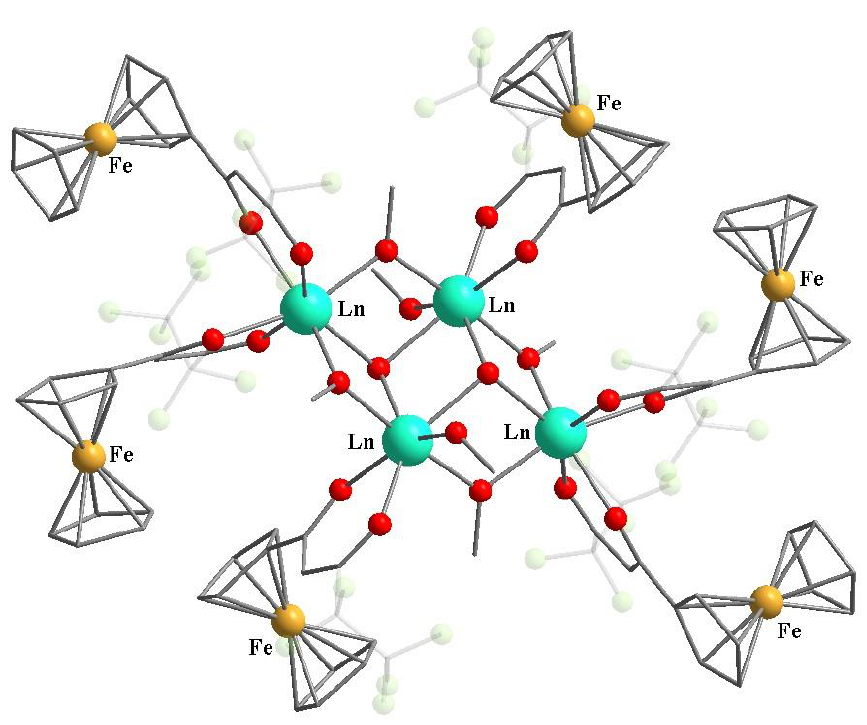
Figure 28. Molecular structure of 54 [97]. Hydrogen atoms have been omitted, C 2 F 5 groups are trans-